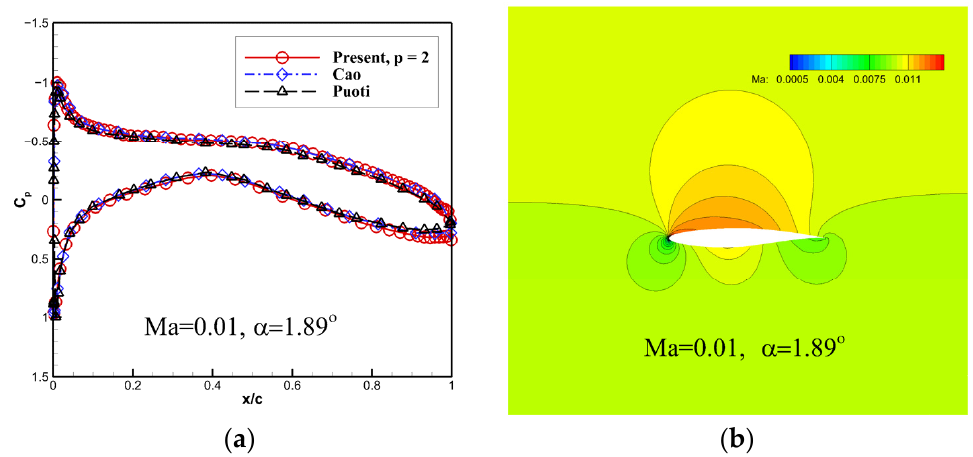
Figure 8. Computational results for the nearly incompressible flow around a RAE2822 airfoil. ( a ) Surface pressure coefficients (Cao [35], Puoti [36]); ( b ) Contours of Mach number.